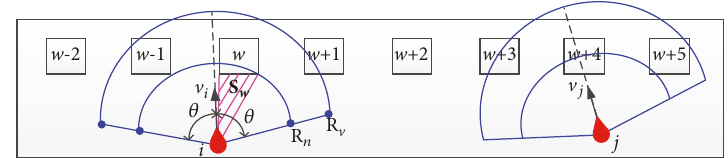
Figure 3: Illustration of passenger motions at the platform.